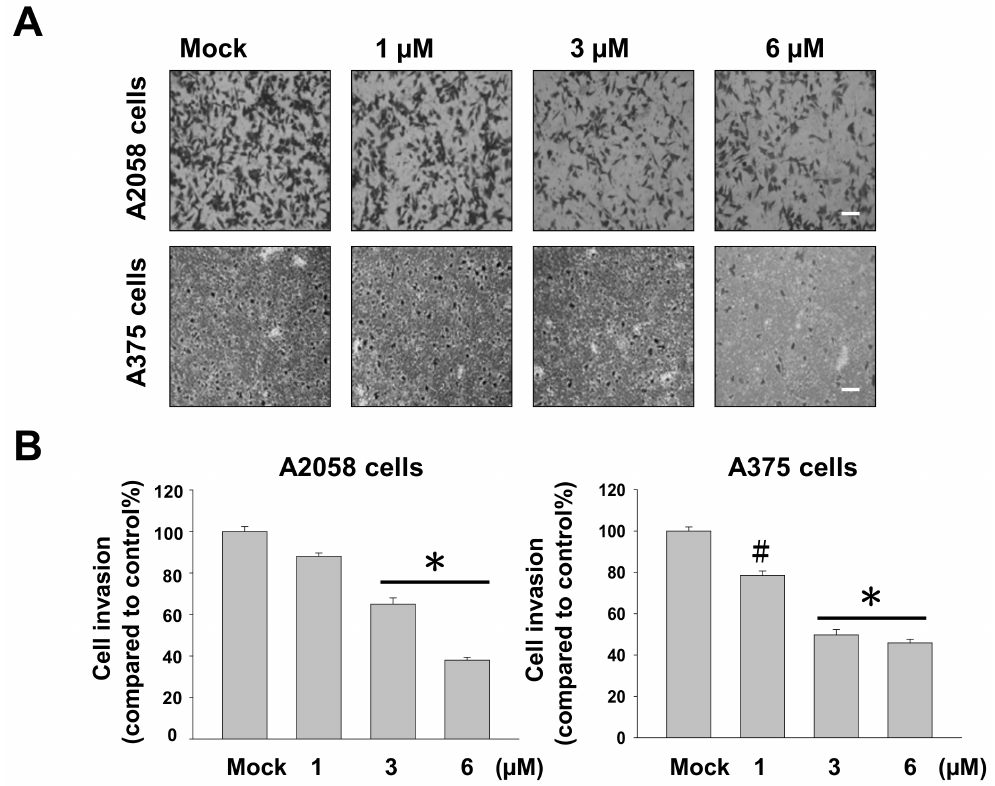
Figure 3. Inhibition effect of bornyl cis -4-hydroxycinnamate on A2058 and A375 cell invasion through Matrigel-coated transwells. ( A ) Bornyl cis -4-hydroxycinnamate significantly reduced the numbers of A2058 and A375 cells that invaded through the membrane as compared with the controls. The results shown here are representative of three independent experiments. Mock: cells treated with vehicle control (DMSO). Scale bars = 20 µ m; ( B ) Quantitative analysis of three independent experiments showed that bornyl cis -4-hydroxycinnamate suppressed A2058 and A375 cell invasion in a dose-dependent manner (# p < 0.05, * p < 0.001 as compared with